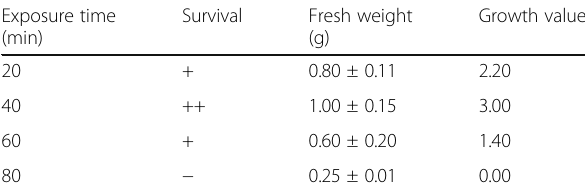
Table 3. Regrowth of cryopreserved callus of globe artichoke exposed for different time to dimethylsulfoxide Exposure time Survival Fresh weight (min) (g)